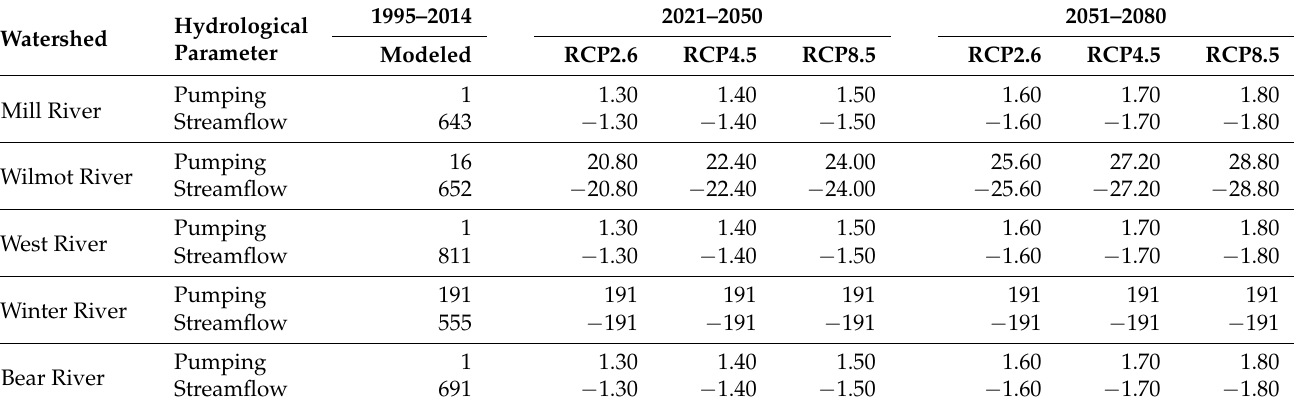
Table 3. Anticipated pumpings and adjustments made in simulated streamflows